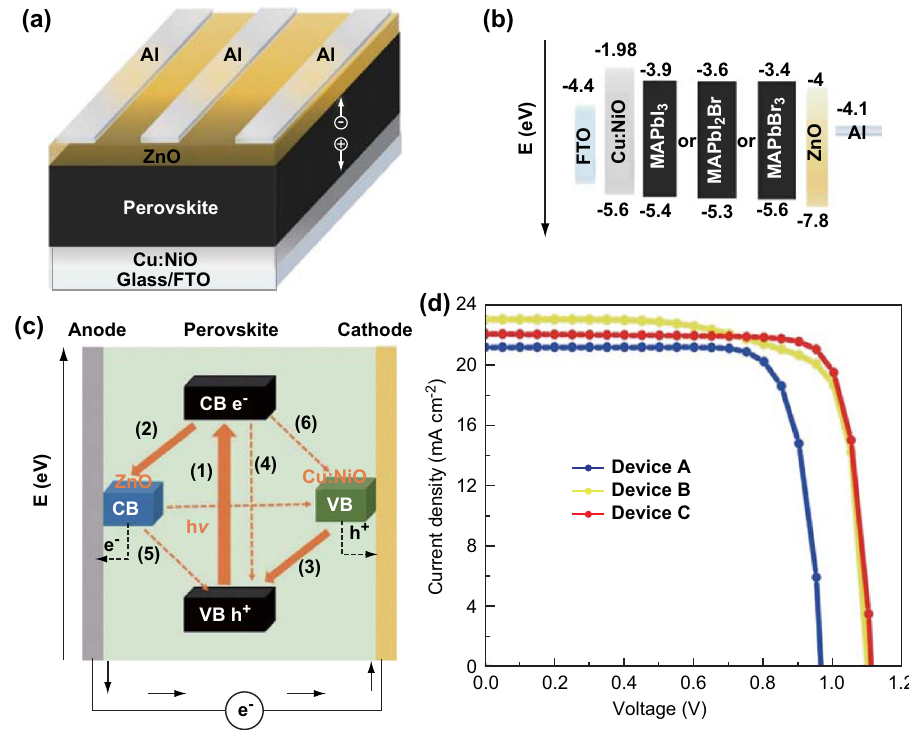
Fig. 1 a Schematic crosssection of p – i – n perovskite solar cells. b Energy band diagram of the corresponding heterojunctions. c Charge generation, separation, and extraction processes. d Simulated J – V characteristic curves under AM1.5G illumination at 100 mW cm - 2